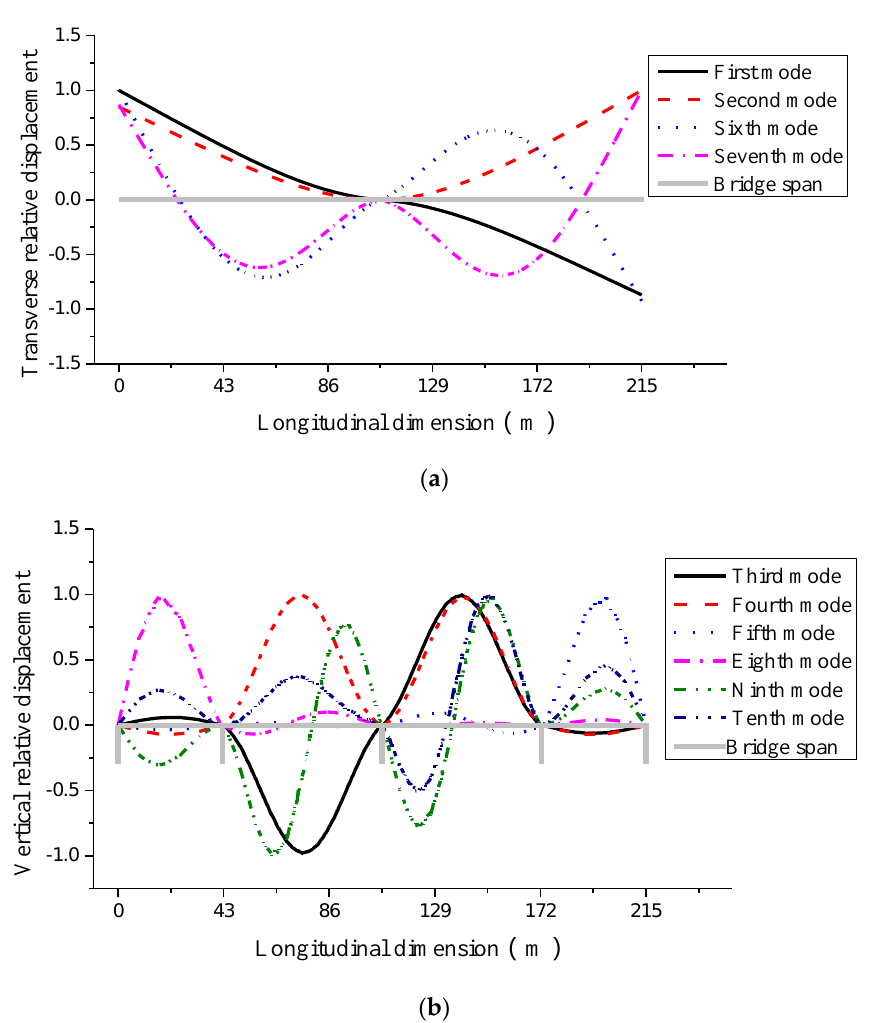
Figure 5. The first ten bending mode shapes of the bridge. ( a ) Lateral mode of the bridge; ( b ) Vertical mode of the bridge.